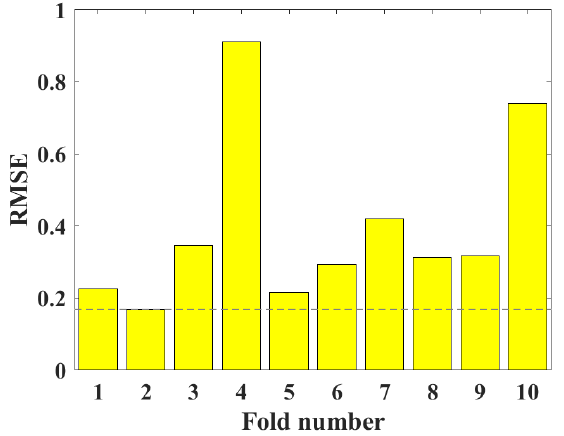
Figure 10. Ten-fold CV for hyperparameter tuning on the UCS dataset of CPB.